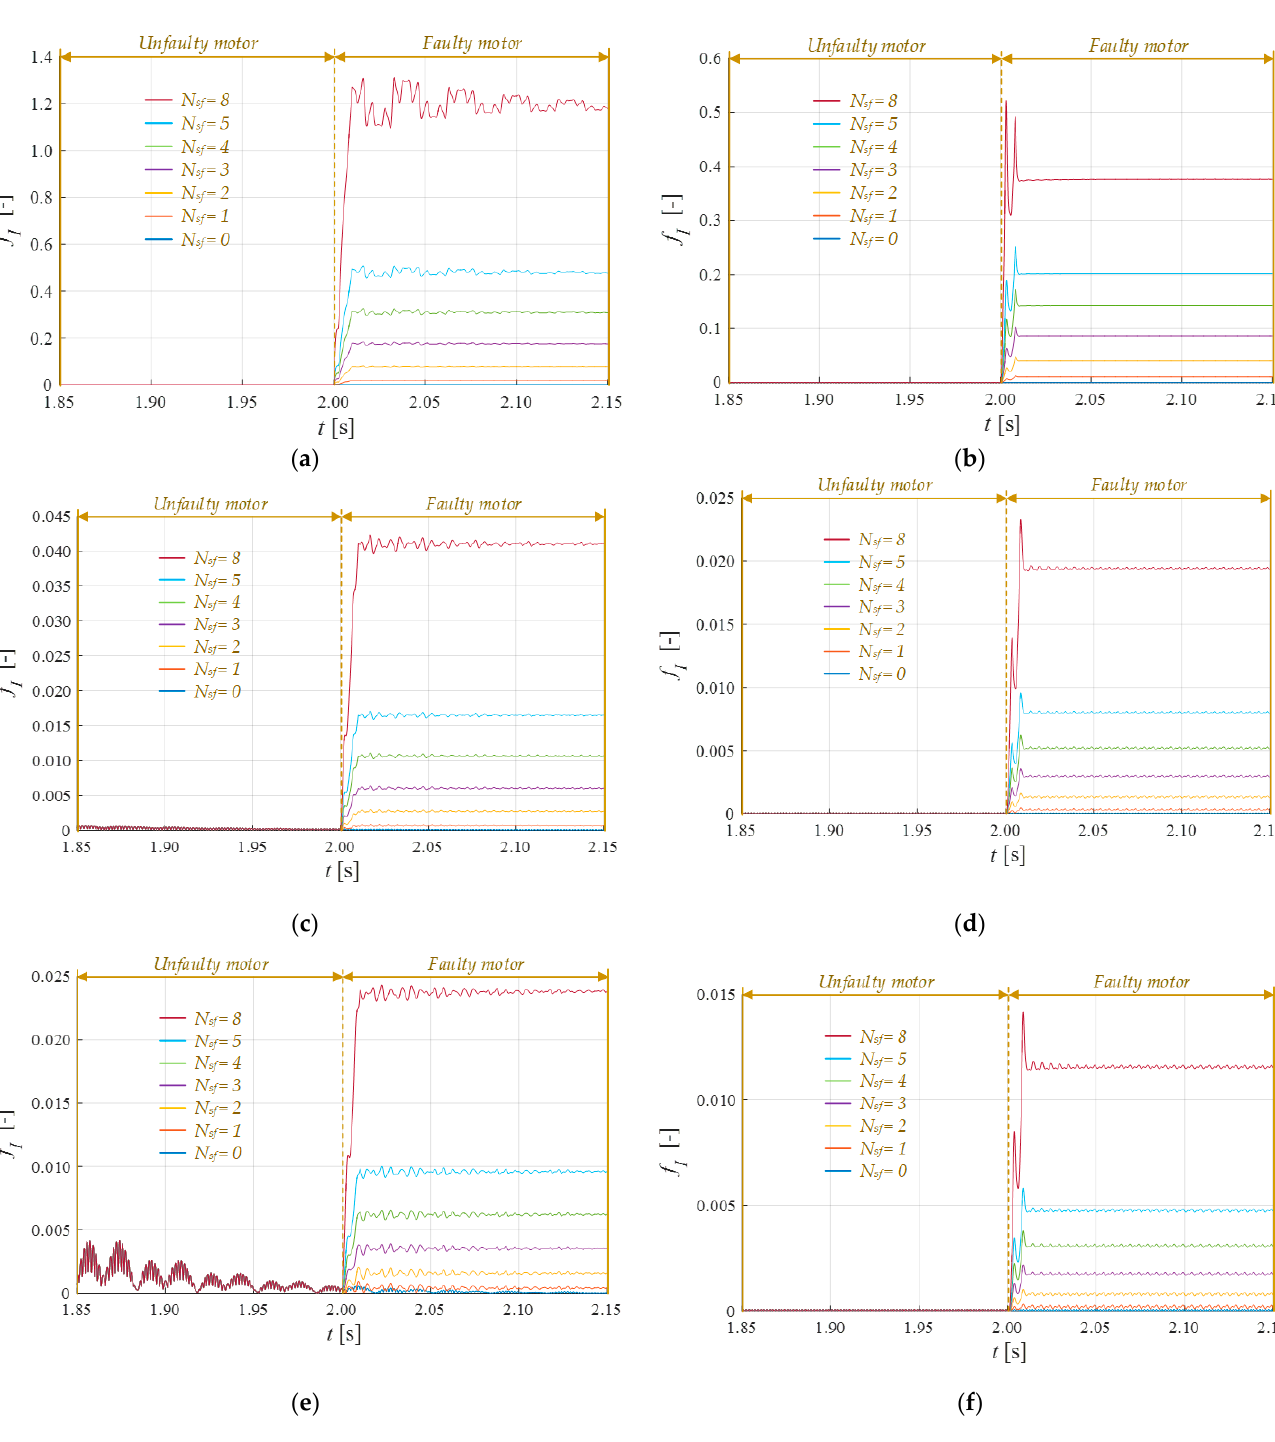
Figure 14. Waveforms of the failure index f i for the operating frequency f s =100 Hz: scalar control ( a , c , e ); field-oriented control ( b , d , f ); for different load torque values: T L ≈ 0 ( a , b ); T L = 0.6 T N ( c , d ); T L = T N ( e , f ).